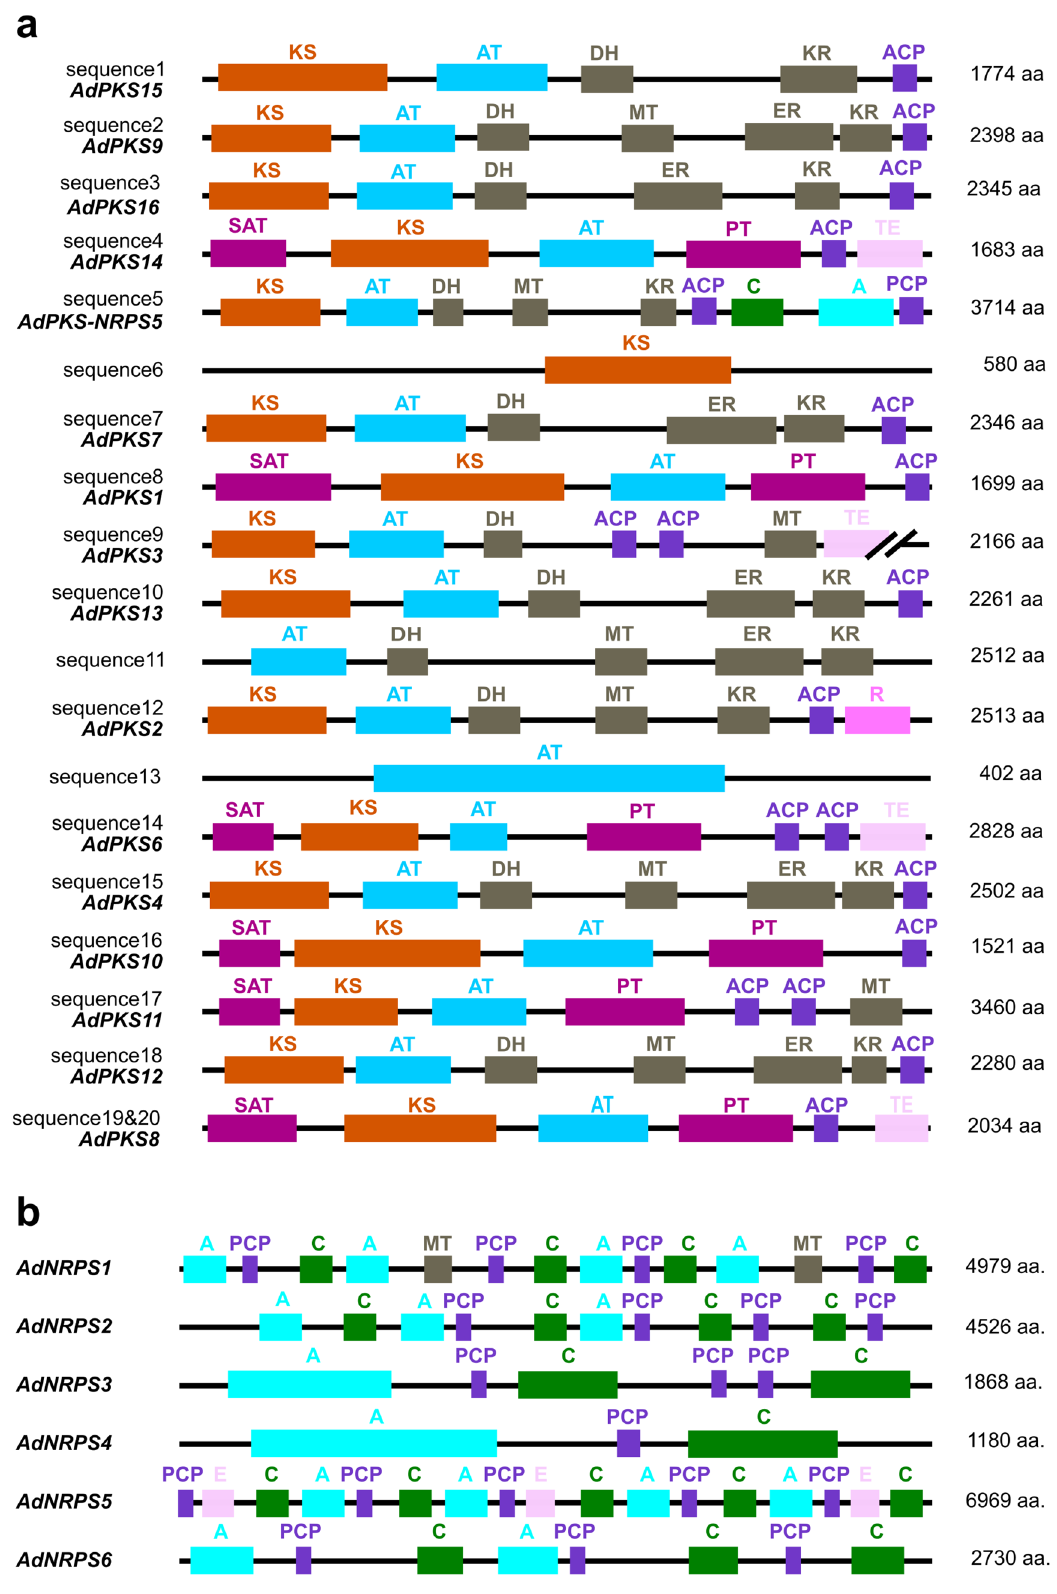
Figure 4. Domain organization of the PKS, PKS-NRPS hybrid and NRPS proteins predicted in the A. dauci genome. ( a ) PKS and PKS-NRPS hybrid proteins, ( b ) NRPS proteins. Abbreviations are as following: A: adenylation